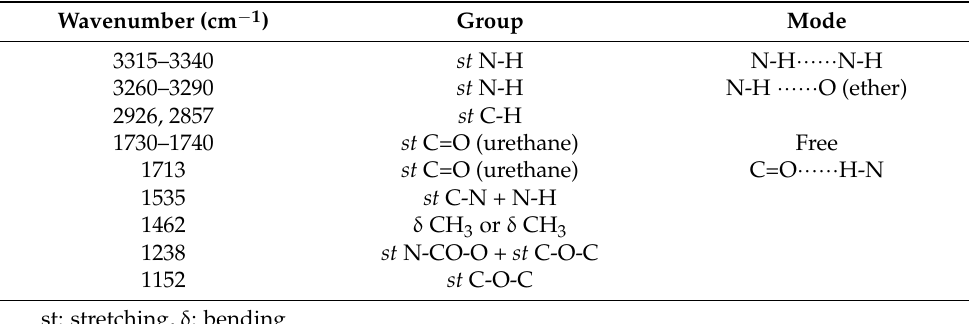
Table 2. Characteristic IR band of JPU film.